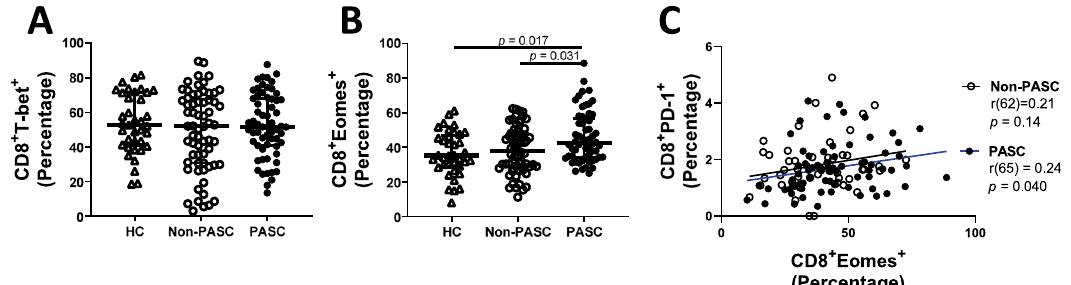
Fig.4|IncreasedlevelsofEOMESinCD8 + TcellsofconvalescentPASCpatients. Percentagesof Tbet + ( A ),EOMES + ( B )CD8 + Tlymphocyteson PBMC of HC( n =37), non-PASC( n =65)andPASC( n =62)individuals.Kruskal – Wallistestwasappliedto identify statistical differences followed by Dunn ’ s multiple comparisons test.